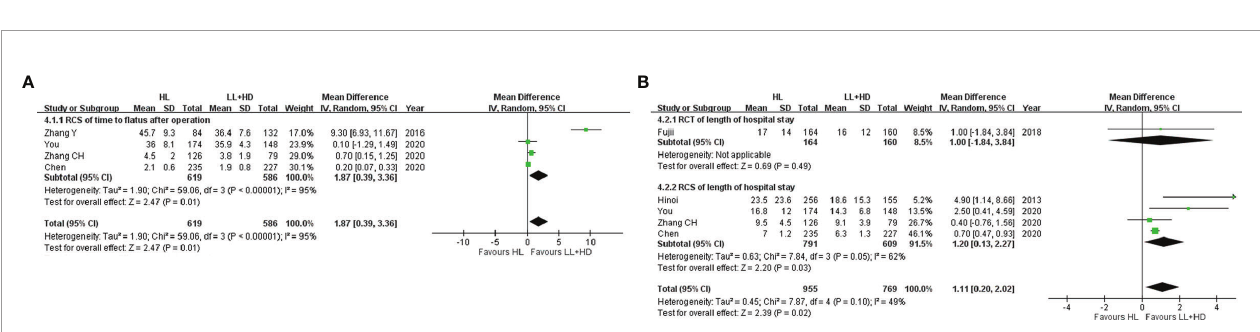
FIGURE 3 | Meta-analysis of intraoperative indices. (A) Forest plot of intraoperative blood loss with HL versus LL+HD. (B) Forest plot of the operative time with HL versus LL+HD. (C) Forest plot of the conversion rate with HL versus LL+HD. (D) Forest plot of diverting stoma with HL versus LL+HD. HL, high ligation of the inferior mesenteric artery; LL+HD, low ligation of the inferior mesenteric artery plus high dissection of lymph nodes.